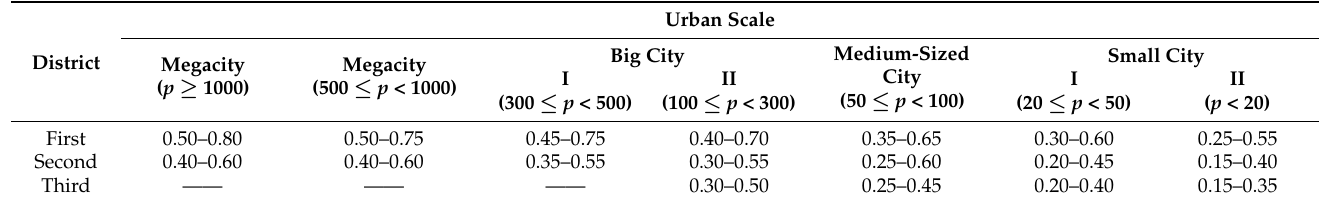
Table 1. Urban comprehensive water consumption index ( × 10 4 m 3 /day per person)